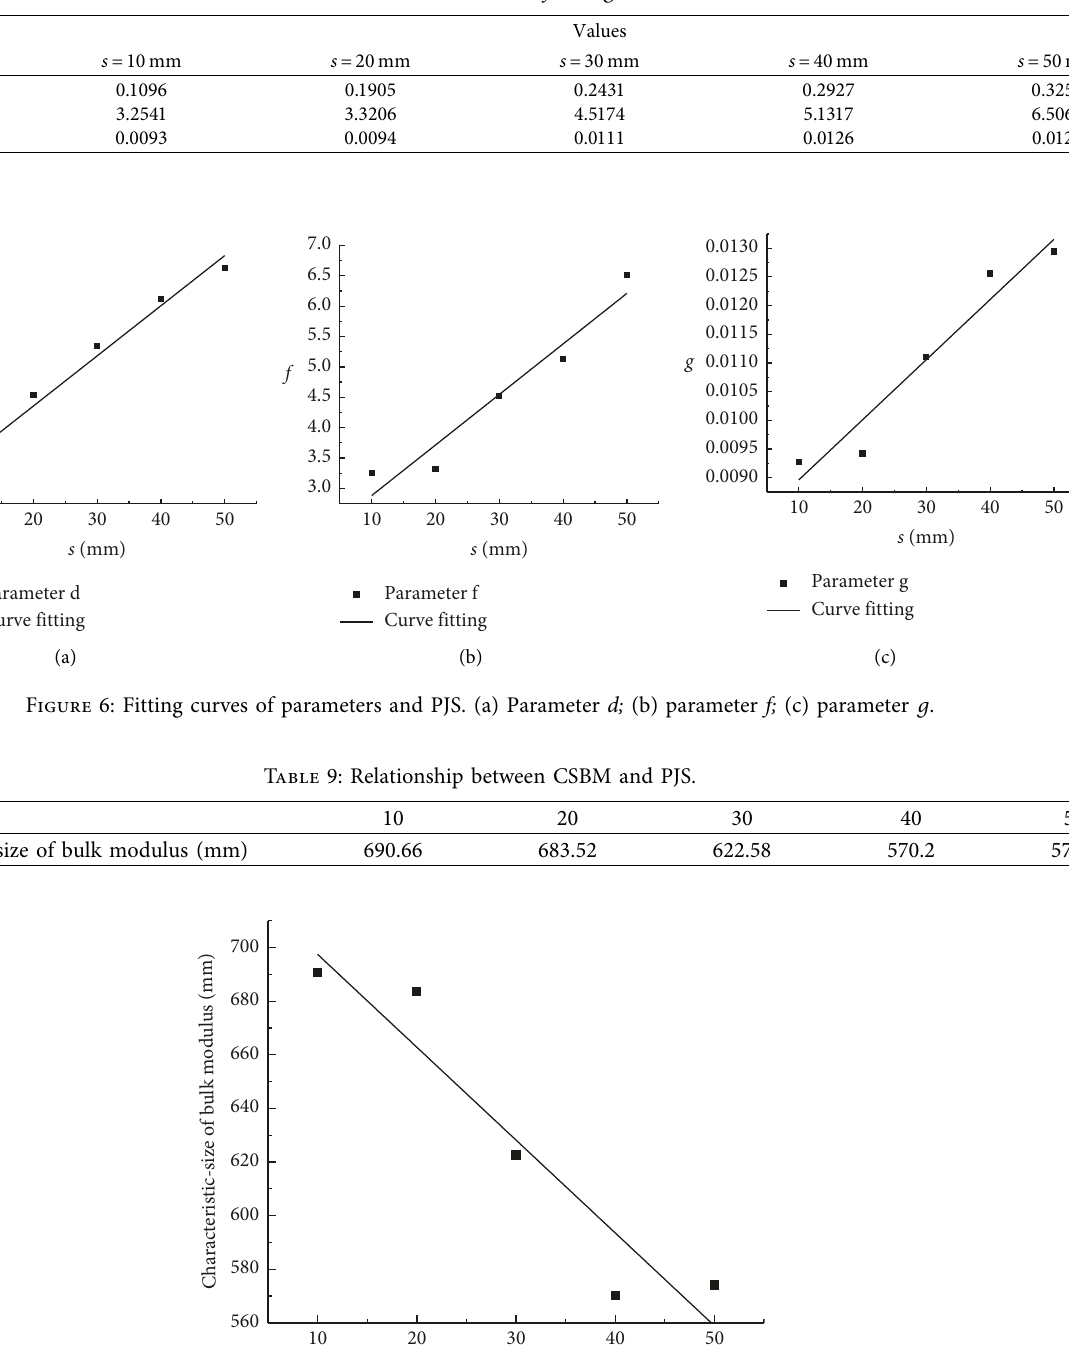
Table 8: Values of d , f , and g.